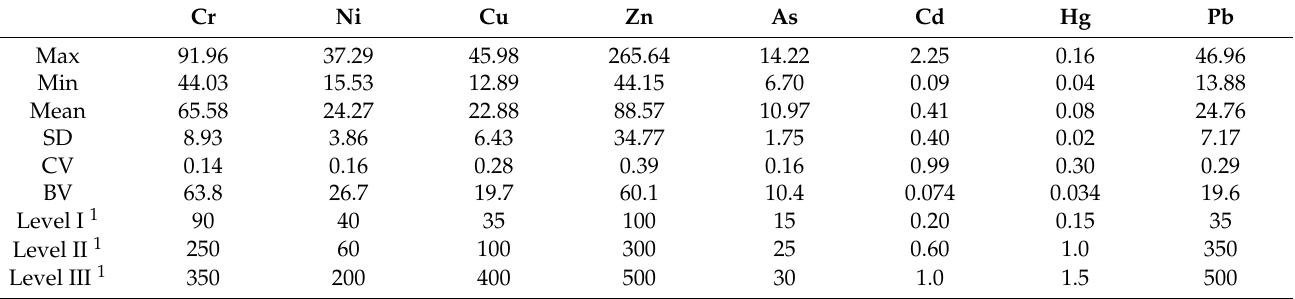
Table 2. Descriptive statistics for PTE concentrations (mg/kg) in roadside soils samples of